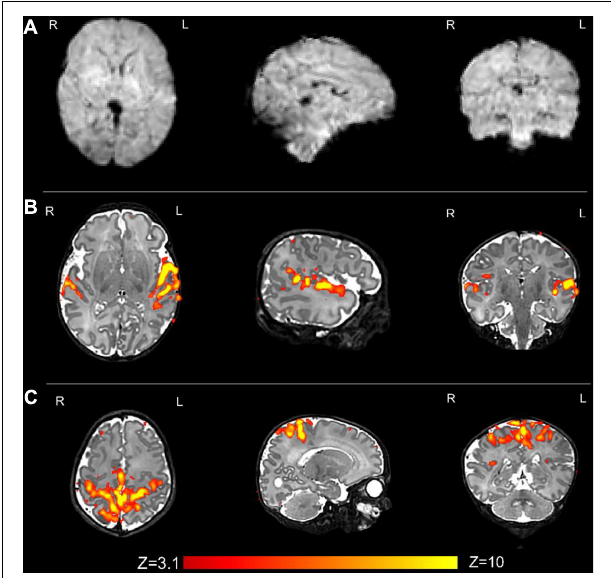
FIGURE 6 | Resting state functional MRI data from the same infant. (A) An example volume from the fMRI acquisition after image reconstruction and the preprocessing pipeline has been applied; and (B) the auditory and (C) sensorimotor resting state networks. Resting state networks were defined using independent component analysis (ICA) as implemented in FSL MELODIC and have been overlaid onto the native T2 image for ease of